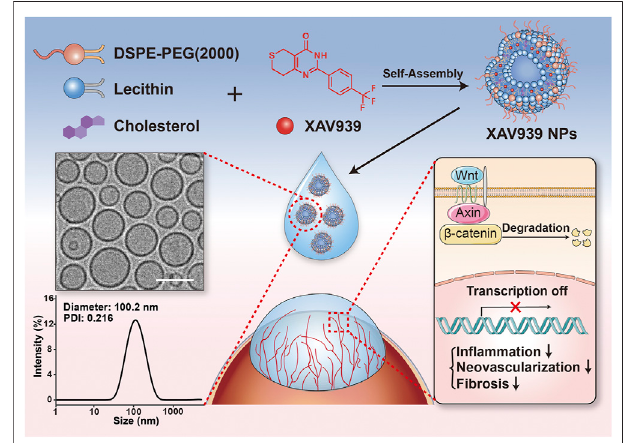
FIGURE 1 | Schematic diagram depicting the XAV939 NPs with corneal wound healing and anti-CNV